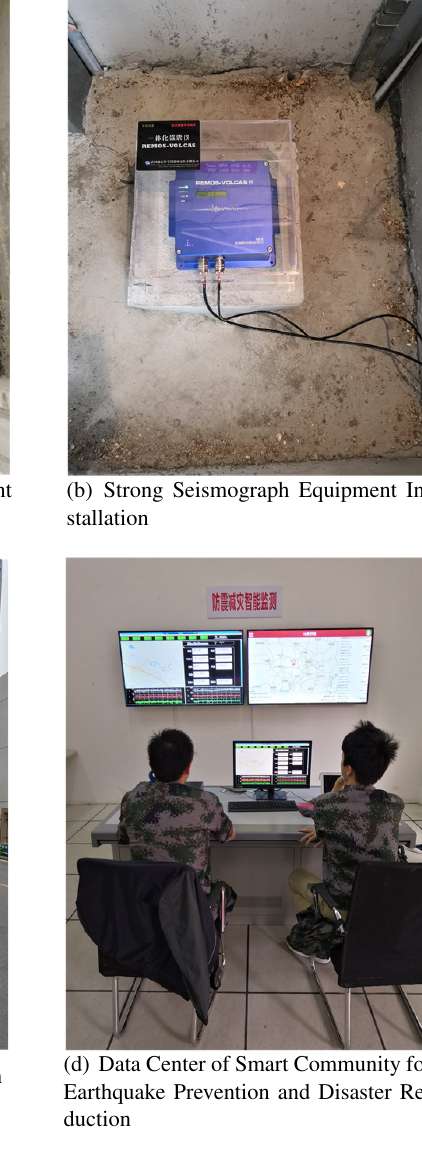
Fig. 3 Installation site map of the Xinheyuan Smart